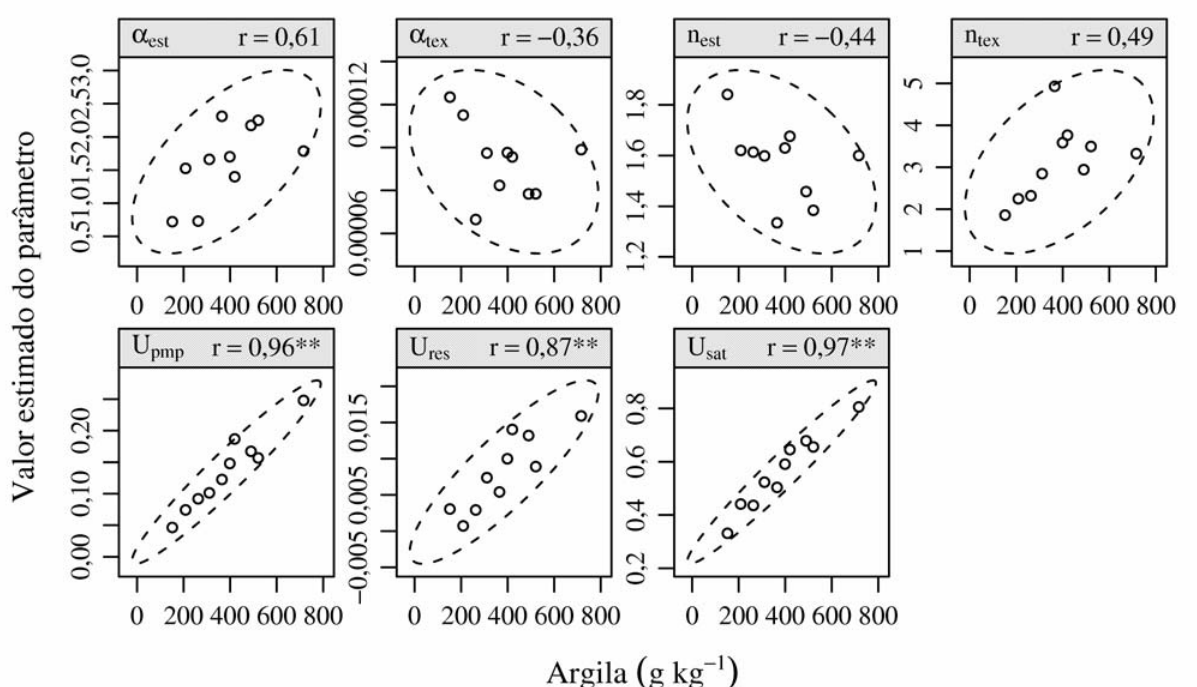
Figura 3. Correlações de Pearson entre os parâmetros de ajuste da equação duplo van Genuchten e o conteúdo de